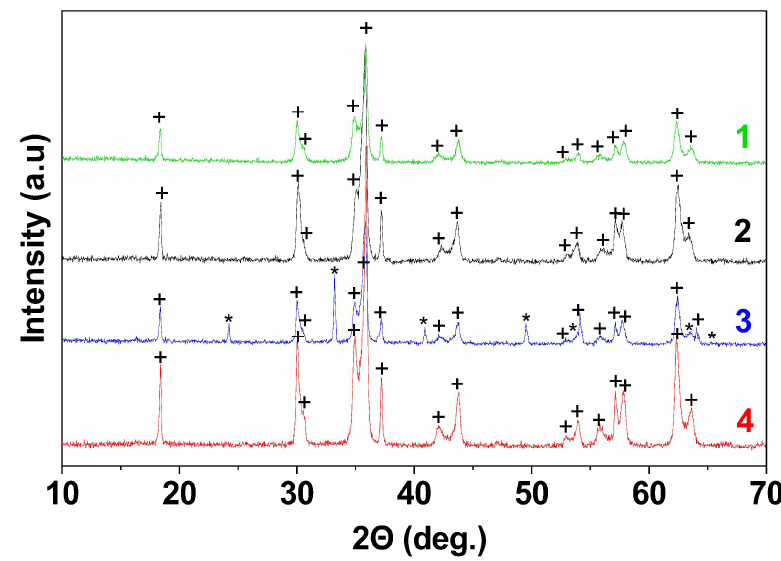
Figure 2. X-ray diffraction patterns of CuFe 2 O 4 powders annealed at 800 °C: 1—sample obtained without polysaccharides, 2—obtained with dextran-40, 3—obtained with dextran-70, 4—obtained with inulin, + CuFe 2 O 4 , * Fe 2 O 3.